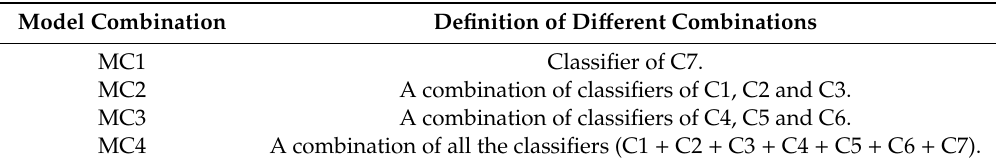
Table 4. Definitions of different model combinations.